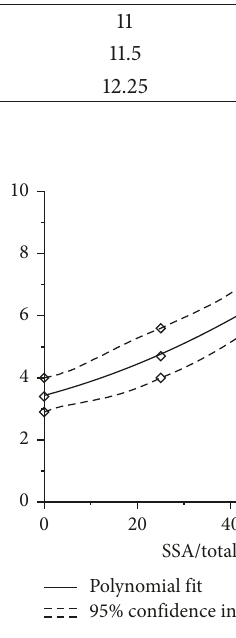
Figure 2: Relationship between the SSA replacement ratio and the slump flow.